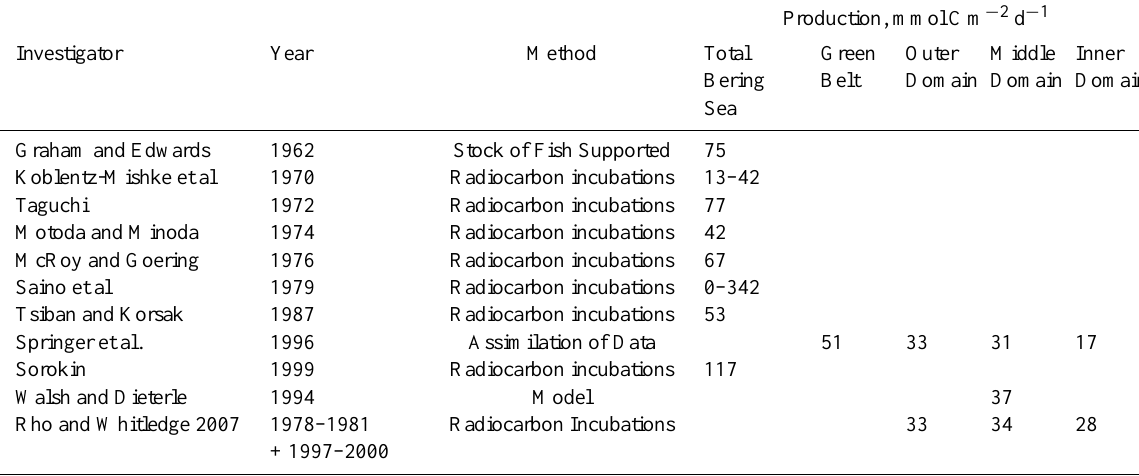
Table 1. Select estimates of primary production in the Southeastern Bering